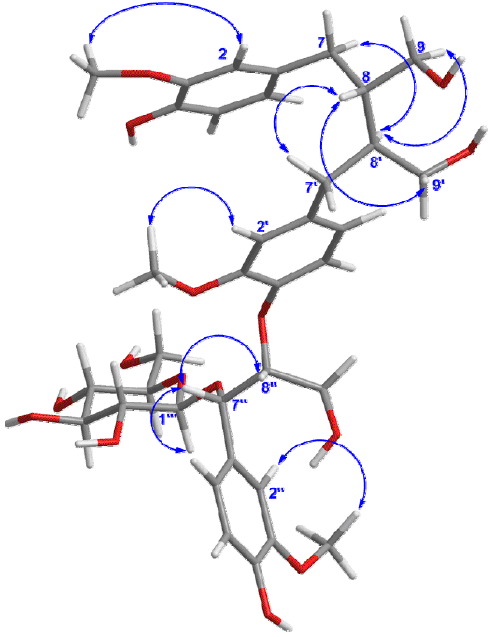
Figure 3. Key NOESY correlations of compound 1